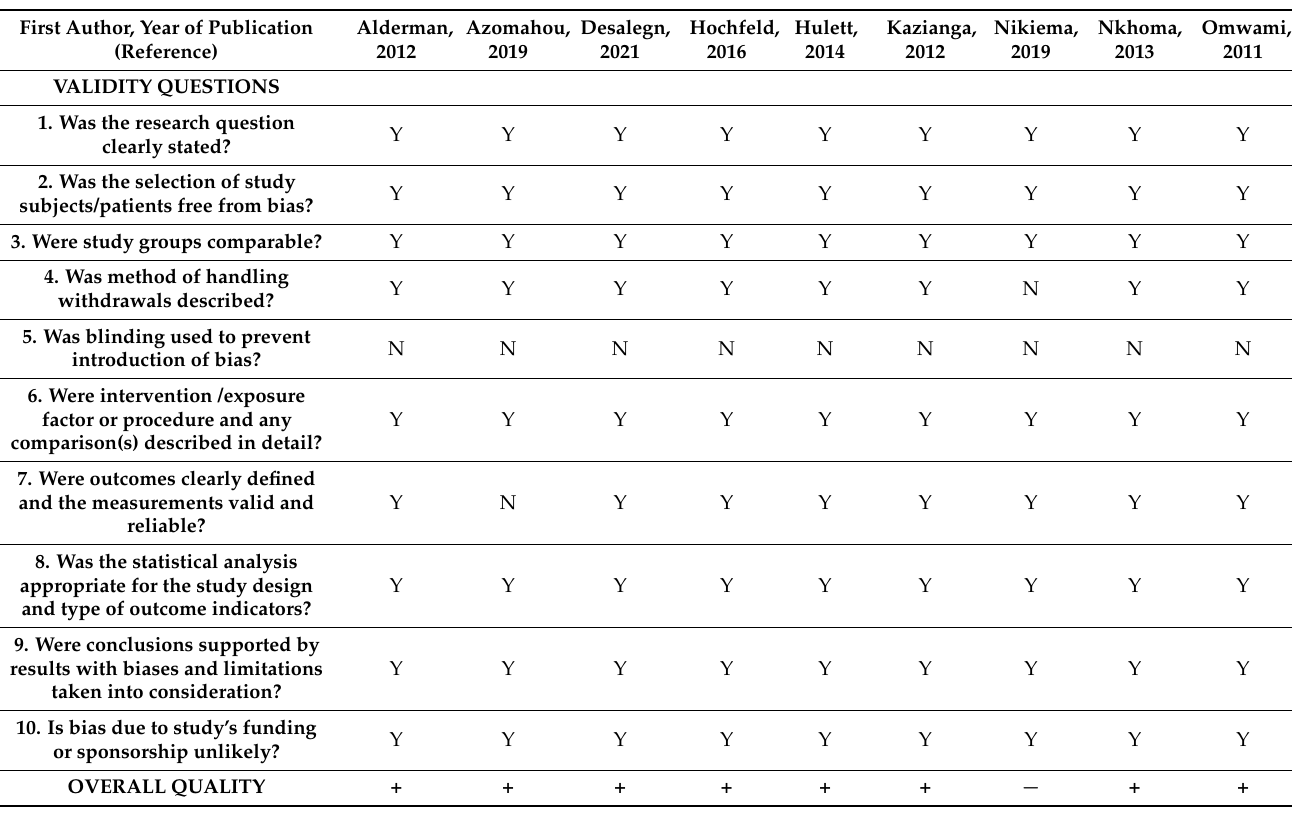
Table A1. Risk of Bias.